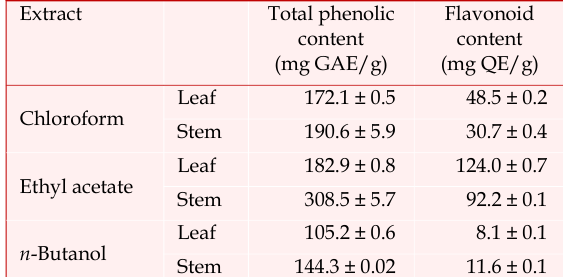
Total phenolic and flavonoid values of G.